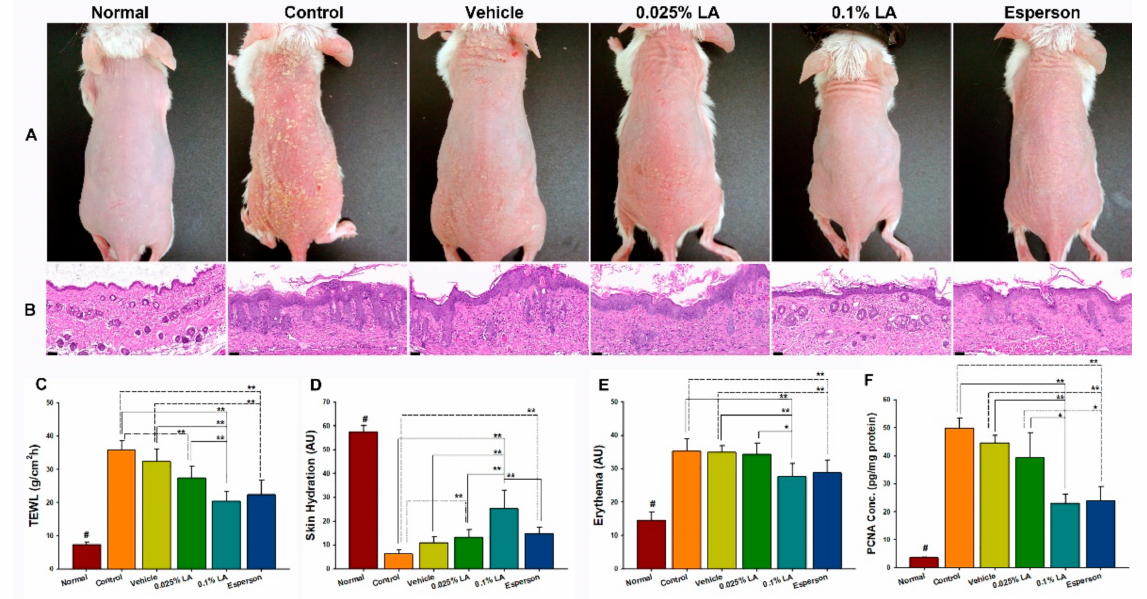
Figure 1. 0.1% LA and DXM improved Psoriasis-like Dermatitis. ( A ) Morphology results show that 0.1% LA and Esperson treatment groups have fewer scaly, erythematous, and dry skin features than other groups. ( B ) The H&E stain results show less acanthosis, parakeratosis, tortuous capillary dilatation in the papillary dermis, and inflammatory cell infiltration in the 0.1% LA and Esperson treatment groups. Scale bar = 50 µ m. ( C ) Transepidermal Water Loss (TEWL), ( D ) Skin hydration, and ( E ) Erythema values show that 0.1% LA and Esperson treatment groups restored barrier function. ( F ) 0.1% LA and DXM treatment inhibited PCNA protein expression. LA, lithospermic acid; PCNA, proliferation cell nuclear antigen; # p < 0.01, compared to all the other groups; * p < 0.05; ** p <